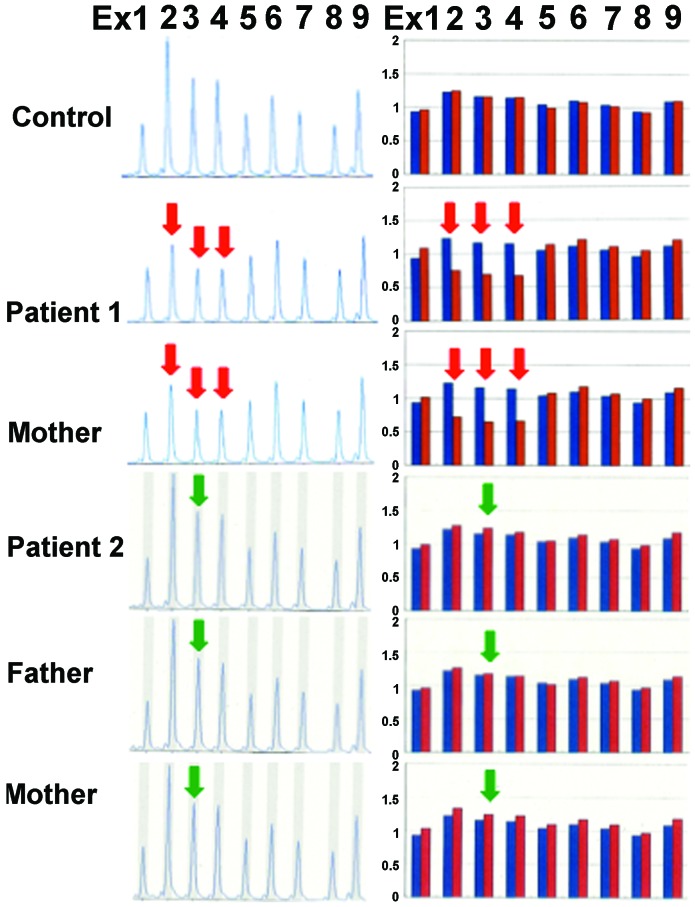
Multiplex ligation-dependent probe amplification (MLPA) of the mitochondrial 3-hydroxy-3-methylglutaryl-CoA lyase (HMGCL) gene. The MLPA profiles of each HMGCL exon are shown. The peaks derived from the P200-A1 reference probes followed by the peak of exon 9 are not shown in this figure. The histogram shows the calculated exonic dosage normalized as described in the Materials and methods. Blue and red columns indicate the dosage in the subject and in one control, respectively. Red arrows indicate that the bands had a significantly decreased dosage compared with the control, indicating that only one copy of exons 2–4 was present in patient 1 and her mother. Patient 2 and his parents had two copies of each exon including exon 3 (green arrows).